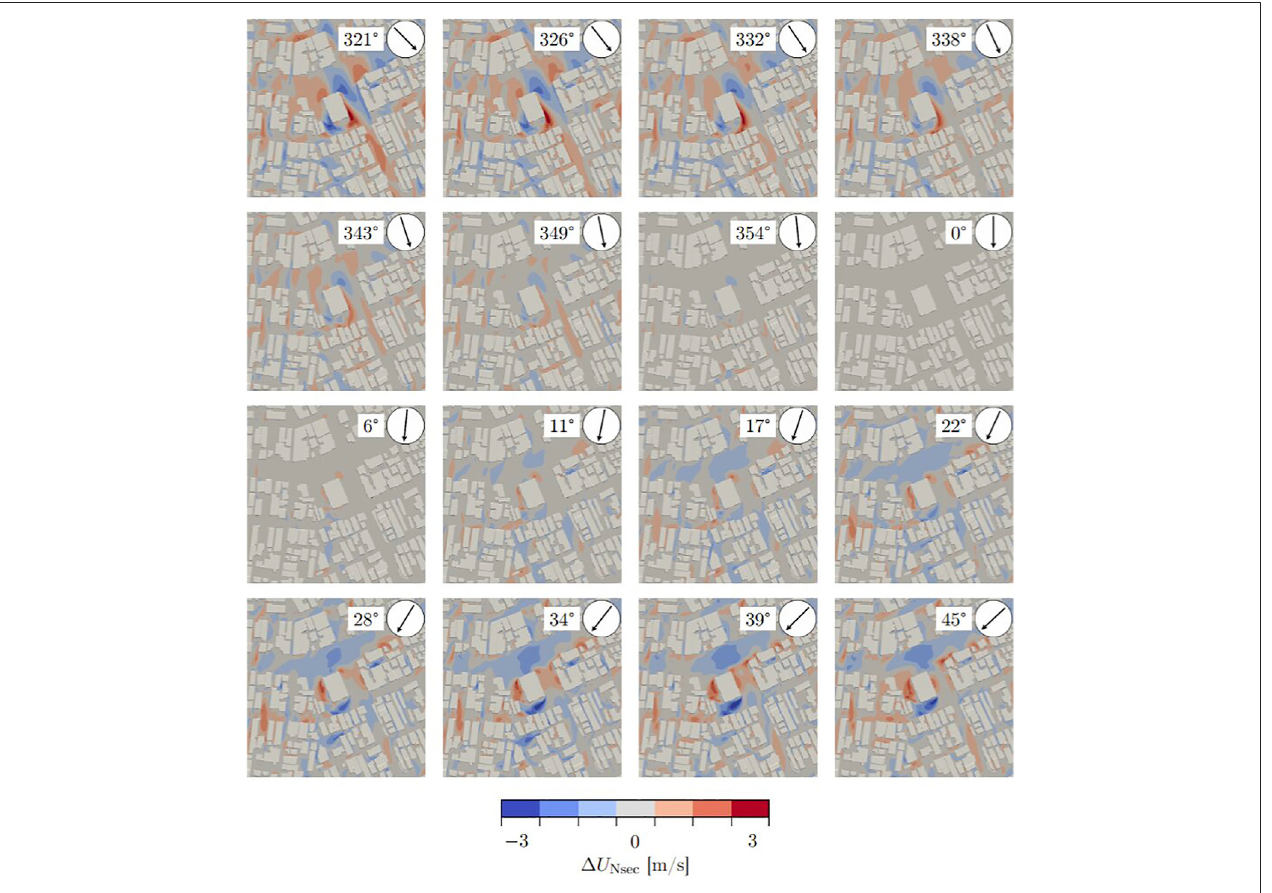
FIGURE6| Windspeeddifference, Δ U Nsec ,toreferencewind directionsimulation at2 maboveground 100 mineach horizontaldirectionofthehigh-risebuilding. The 16 included simulations represent wind from a 90 ° wide sector around the reference wind direction N (0 ° ). The black arrow indicates the wind direction at the inlet.